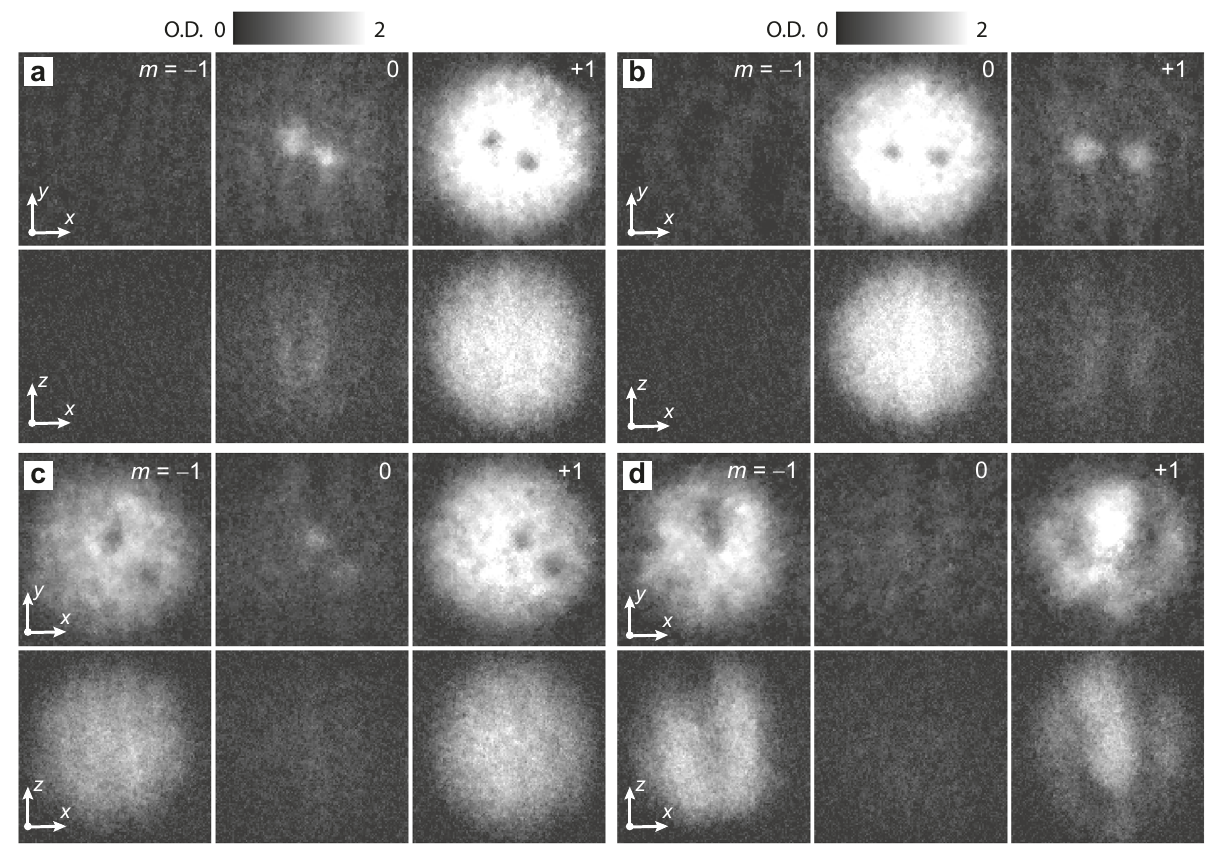
Fig. 5 Three-dimensional nature of several representative condensates with vortices. a The initial SO(3) vortices, after the splitting of the nonsingular texture, with images of the spinor-component column densities taken simultaneously along the z - and y -axes as indicated by the coordinate arrows. b As ( a ) for a pair of polar, singly-quantized vortices (SQVs) after the rapid exchange of the magnetic phases. c As ( a ) for two SQVs after rotating the directors into the xy plane by the radiofrequency π /2-pulse. d As ( a ) for a likely half-quantum vortex candidate after 50 ms of time evolution following the pulse. Each set of panel images within ( a – d ) is from a separate realization of the experiment and shows the spinor-component column densities, integrated along the corresponding imaging axis, with intensity expressed in units of optical depth (O.D., grayscale bar). The fi eld of view of each panel image is 219 μ m × 219 μ